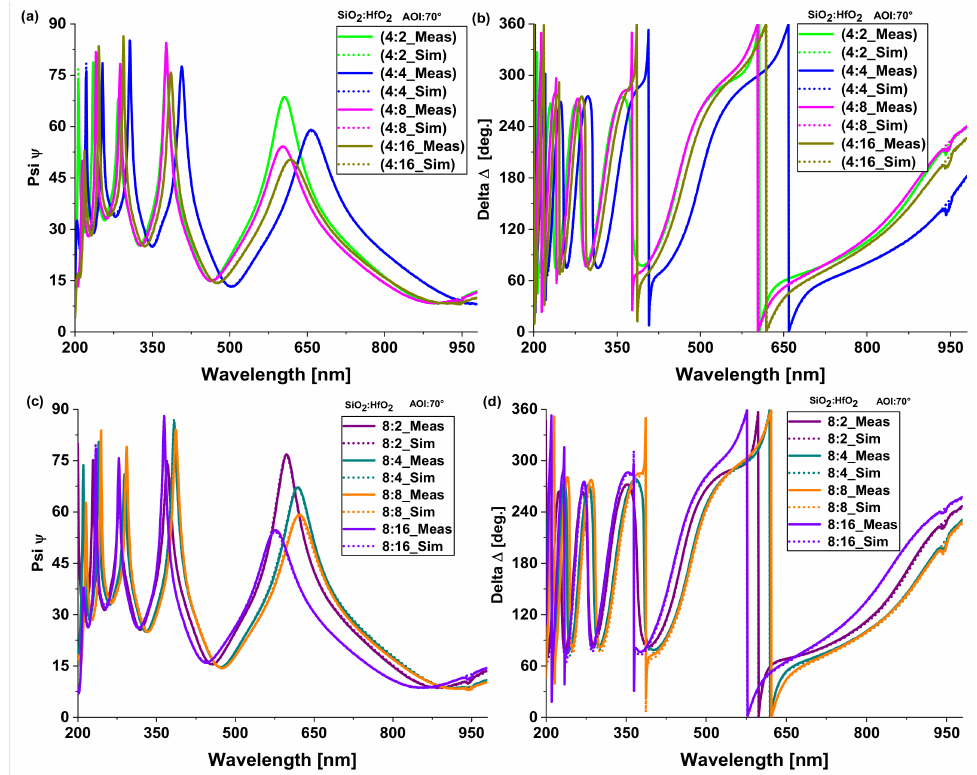
Figure 1. Measured and simulated spectroscopic ellipsometric parameters ( Ψ and ∆ ) for the SiO 2 :HfO 2 heterostructures with ( a , b ) 4 and ( c , d ) 8 cycles of SiO 2